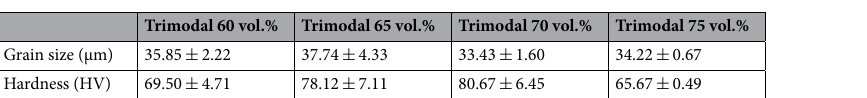
Table 3. Grain size and Vickers hardness measurement results of the sintered trimodal feedstock with 60 vol.%, 65 vol.%, 70 vol.% and 75 vol.% (grain size was determined using ImageJ analysis and hardness measurement was done on 10 different spots for each